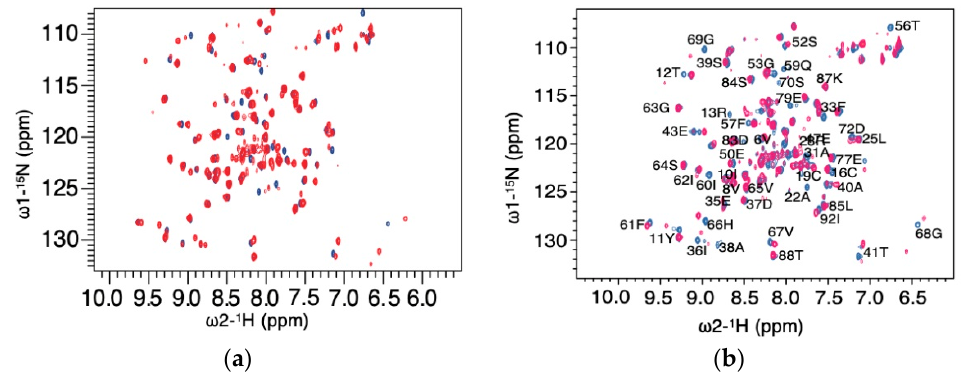
Figure 10. Competitions Studies with GSH ( a ) Cu(I) metalated GRX (blue) with 3.5 eq GSH (red); ( b ) Ag(I) titrated GRX (blue), 16 mM GSH with 0.5 eq silver titrated GRX (pink).